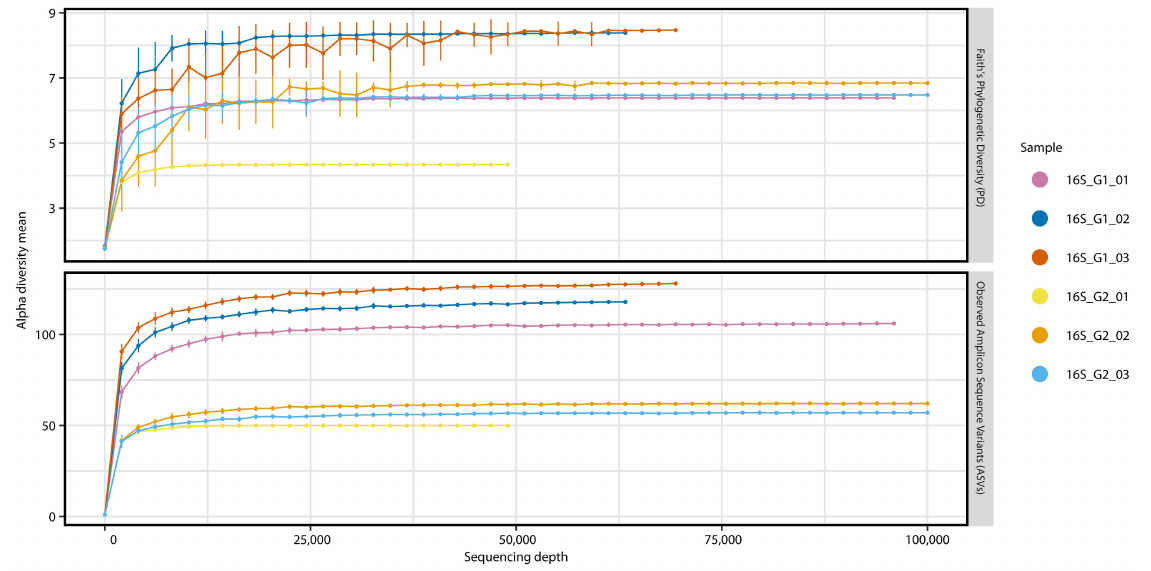
Figure 1. Rarefaction curves of 16S rRNA gene sequencing for all samples. All curves reached a plateau, showing that greater sequencing depth would not influence the microbial diversity found in the sequencing data (Faith’s phylogenetic diversity and observed amplicon sequence variants). Standard deviations are shown as